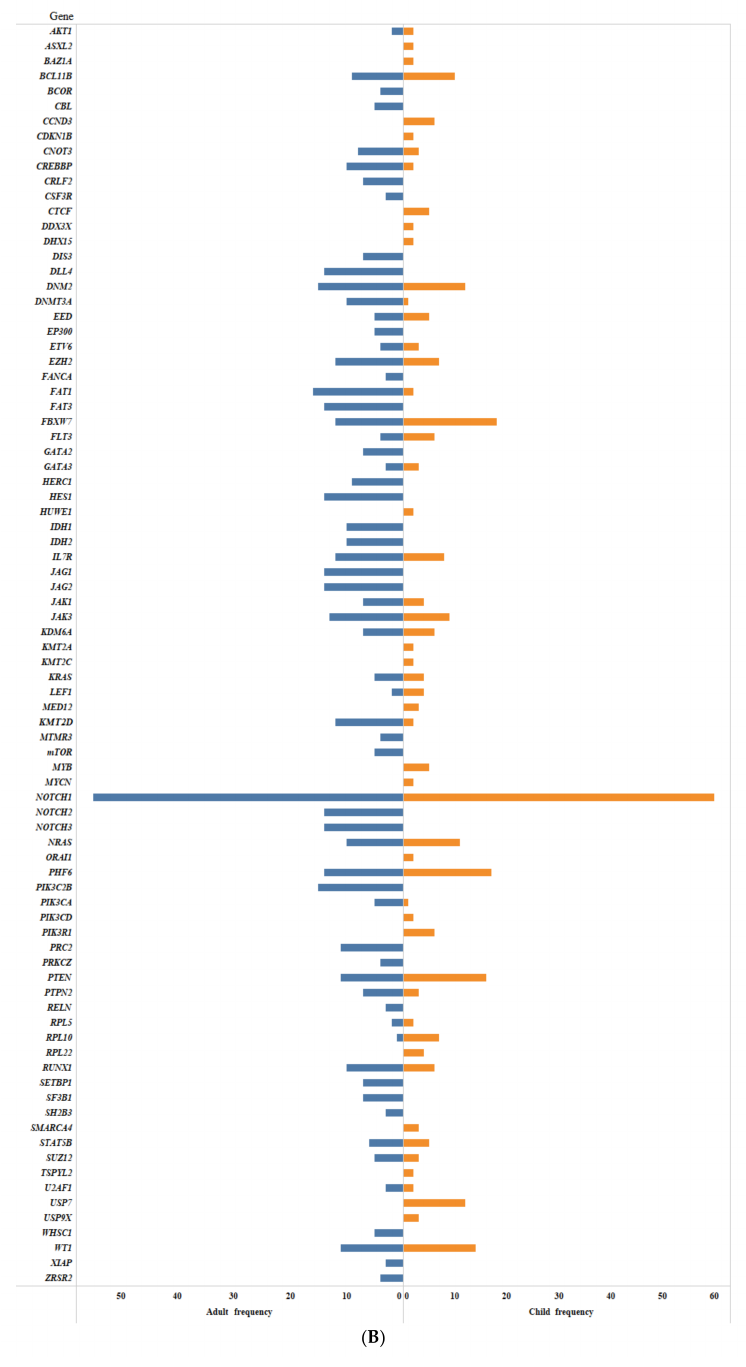
Figure 2. ( A ) Frequency of somatic mutations identified by NGS methods in B-ALL. The figure shows the frequency of somatic mutations in childhood and adult B-ALL. ( B ) Frequency of somatic mutations identified by NGS methods in T-ALL. The figure shows the frequency of somatic mutations in childhood and adult